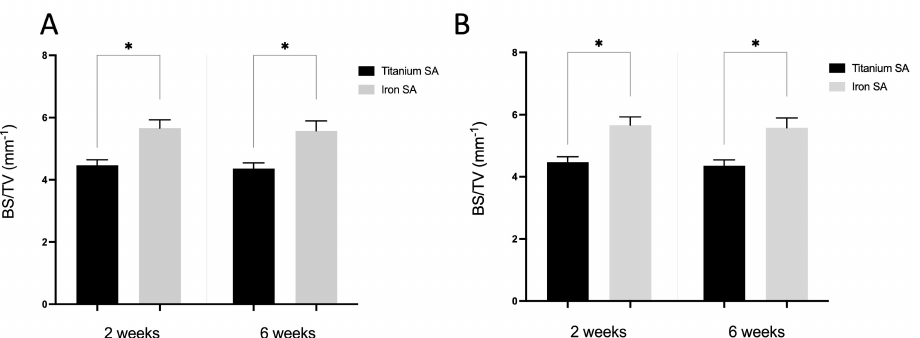
Figure 10. Micro-computed tomography (micro-CT) analysis. Quantitative evaluation of the bone volume (BV) between the bone and SAs. The tissue volume (TV, mm 3 ), BV (mm 3 ), and BS (mm 2 ) were examined in a region of interest (ROI) of 200–1000 μ m around the implant. ( A ) BV fraction (BV/TV, %) and ( B ) BS density (BS/TV, mm − 1 ) represent the BV rate and bone tissue surface rate, respectively. Mean ± SEM. * p < 0.05.